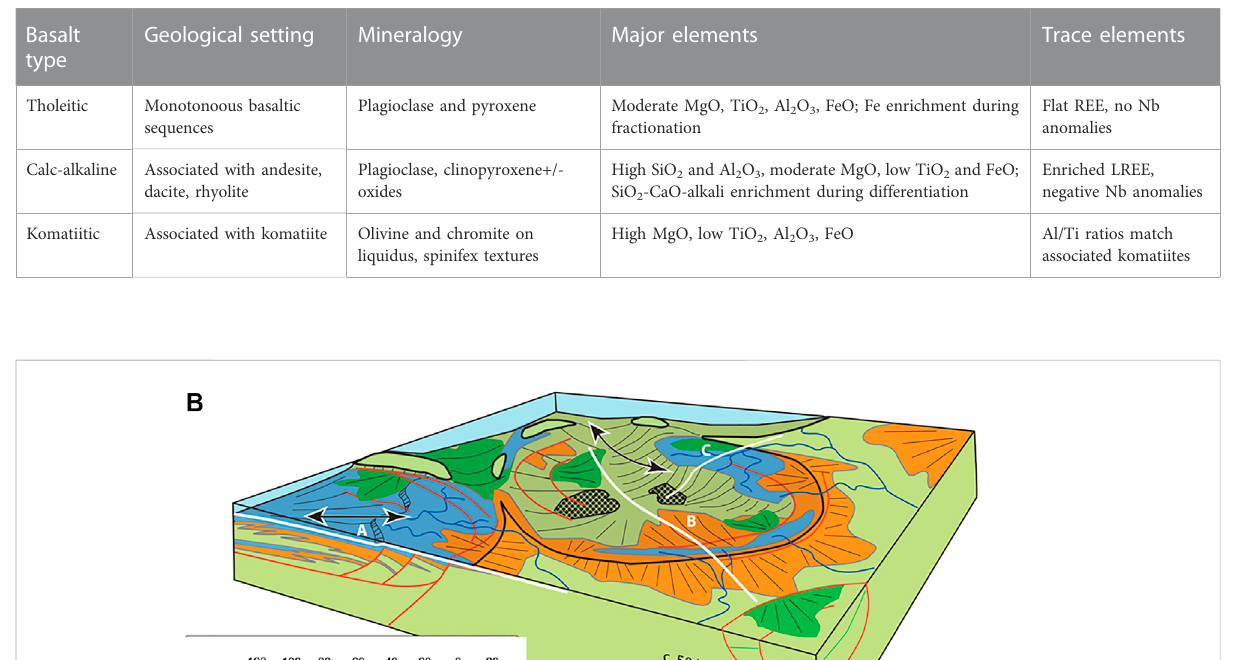
TABLE 3 Characteristics of Archaean basalts (Barnes and Arndt, 2019).